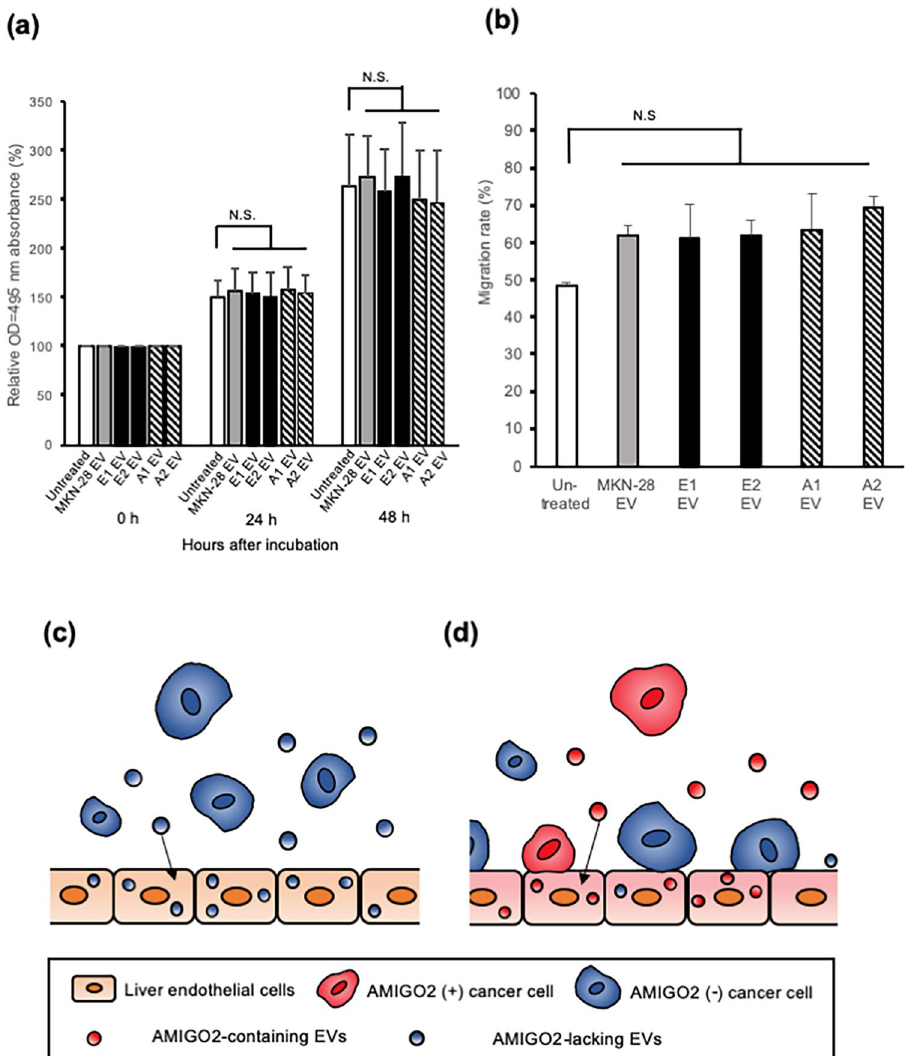
Figure 4. EVs-derived AMIGO2 did not affect HHSEC proliferation and migration. ( a ) HHSEC proliferation was evaluated using crystal violet assay. Bar graphs show mean ± SD (n = 10 in each group). This experiment was performed at 2 times. N.S., no significance based on the Dunnett’s test. ( b ) Wound-healing assays were performed to evaluate the migration of HHSECs. Bar graphs show mean ± SD (n = 5 in each group). This experiment was performed at 3 times. Typical data were presented in Supplementary Fig. S7. * P < 0.05 (Dunnett’s test). N.S., no significance on the Dunnett’s test. ( c ) AMIGO2(-) EVs incorporated into liver endothelial cells do not enhance their adhesion to cancer cells. ( d ) When AMIGO2(+) EVs are incorporated into liver endothelial cells, AMIGO2(+) cancer cells as well as AMIGO2(-) cancer cells adhere to the endothelial cells. AMIGO2(-), AMIGO2-dificient cells; AMIGO2(+), AMIGO2-containing